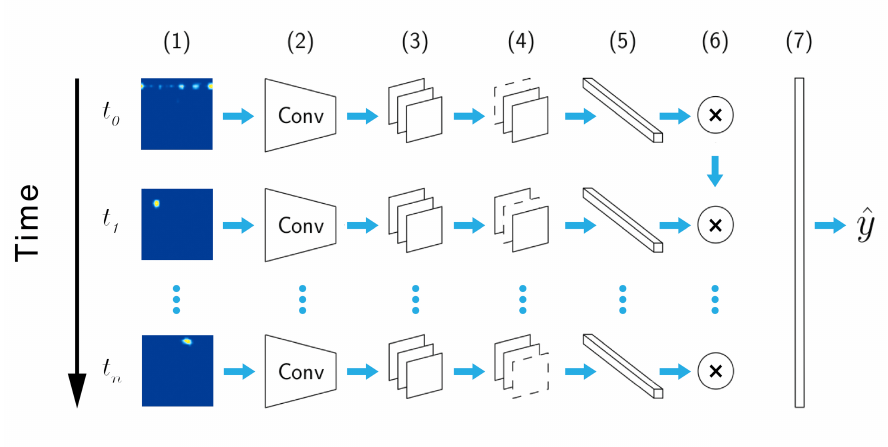
Figure 2. Hybrid deep learning model architecture. Range Doppler images (1) are processed with a stack of CNN layers (2) that extract feature maps followed by maxpooling (3) and spatial dropout (4) layers. Then, a fully connected layer (5) creates the feature vectors for a recurrent LSTM layer with a dropout (6) and finally, a softmax layer (7) outputs the gesture class prediction ( ˆ y